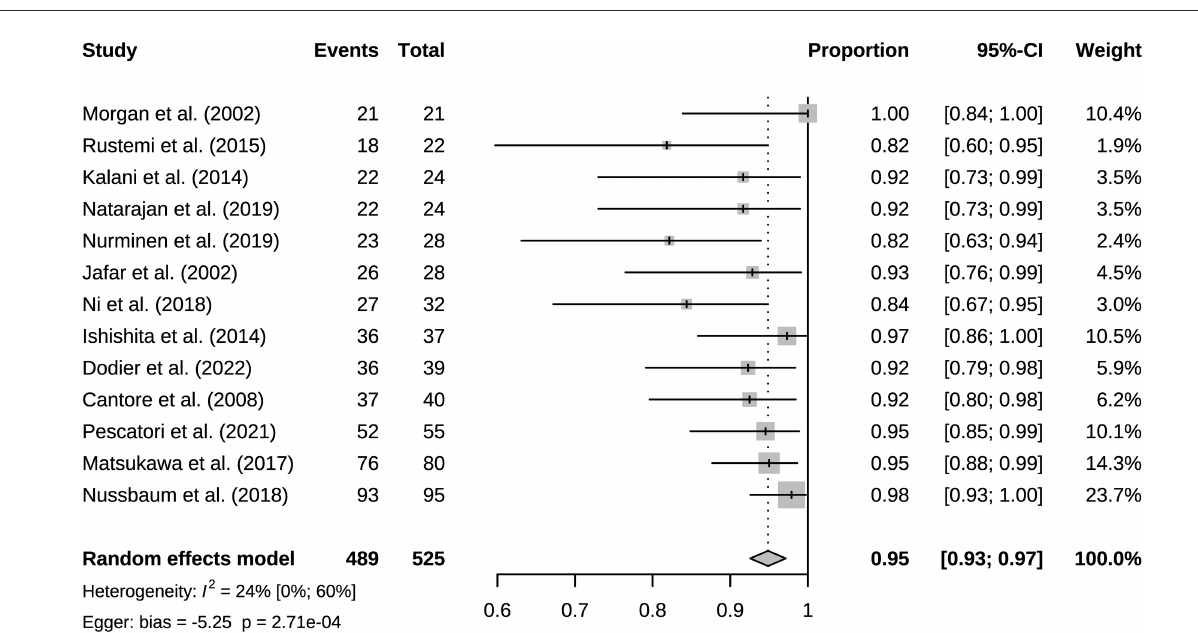
FIGURE4 Long-term follow-up bypass patency of included studies.